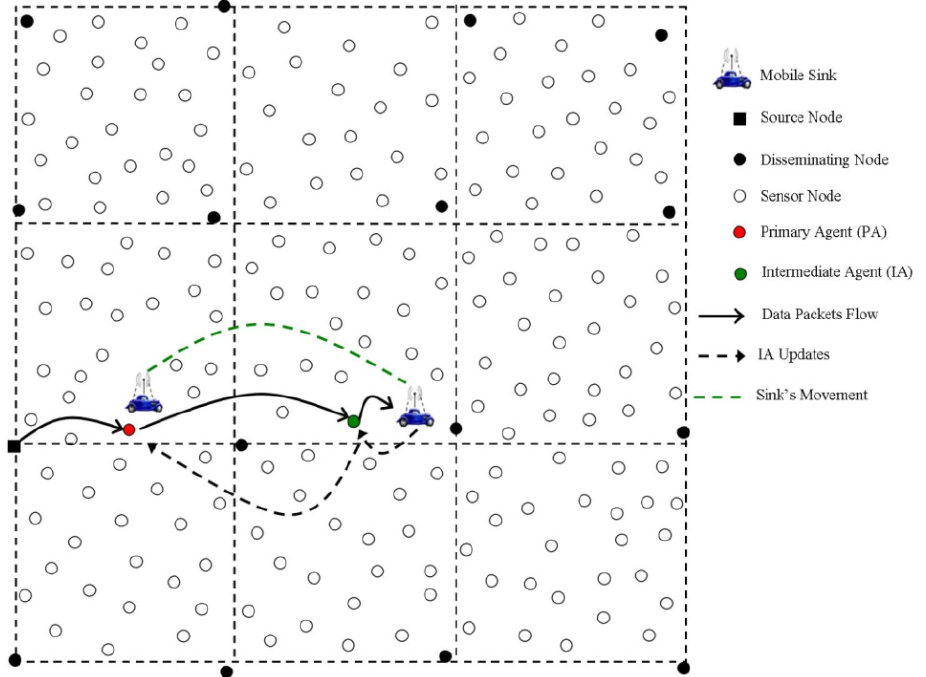
Figure 10. Handling sink mobility in